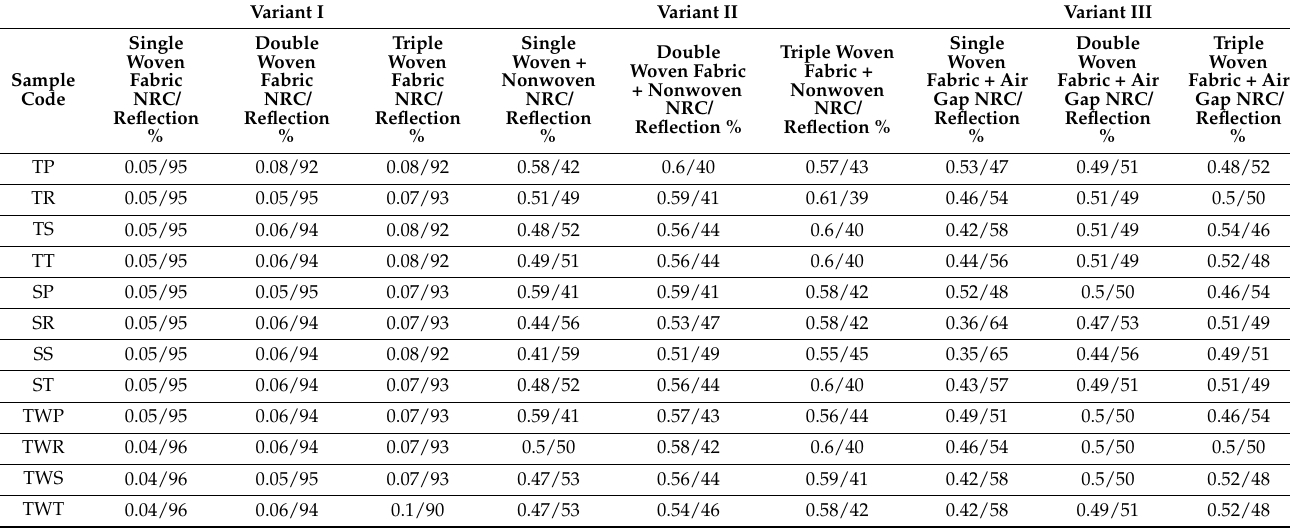
Table 4. Percentage of noise reduction coefficient (NRC) of the